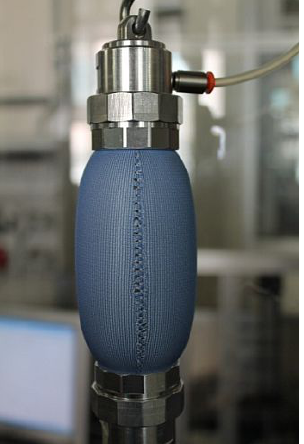
Figure 4. Prototype of a DIMEAS textile pneumatic muscle during testing.